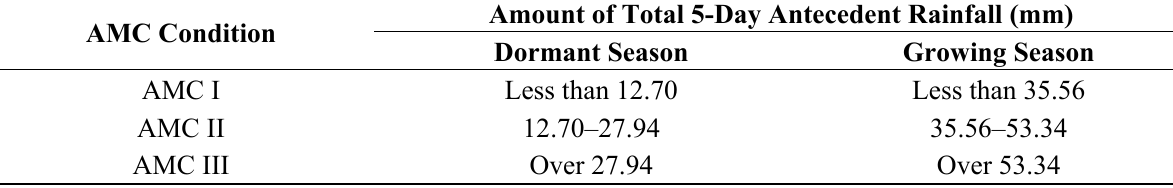
Table 2. Classification of AMC condition [82].